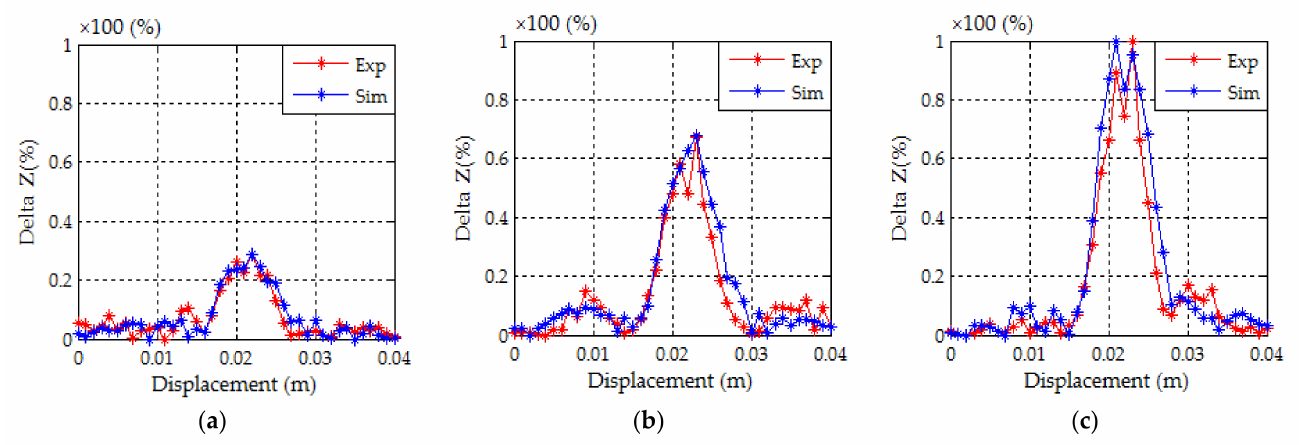
Figure 12. Impedance variation in (%) at 40 kHz with ( a ) depth = 0.3 mm, ( b ) depth = 0.5 mm, and ( c ) depth = 1 mm.